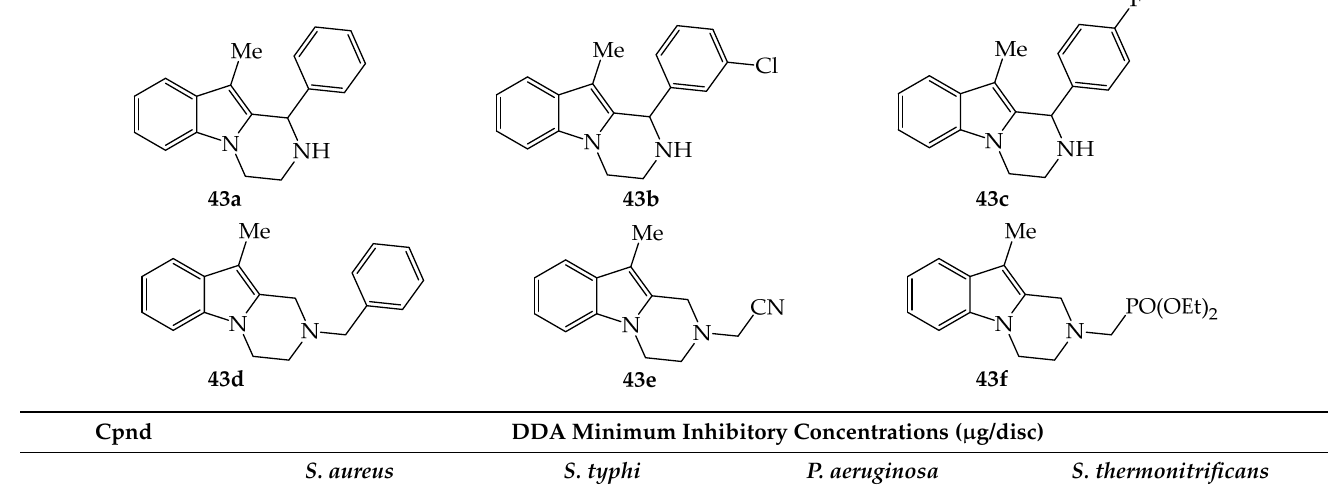
Table 1. Anti-bacterial properties of tetrahydro-pyrazinoindoles 43a–f .